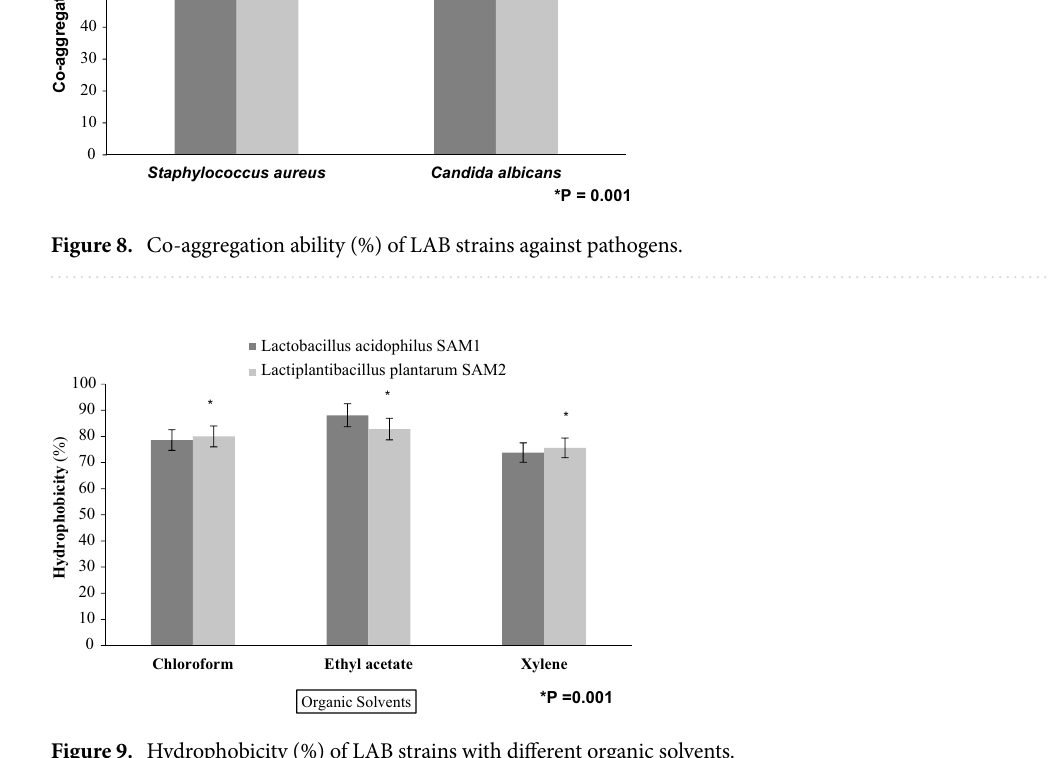
Figure 9. Hydrophobicity (%) of LAB strains with different organic